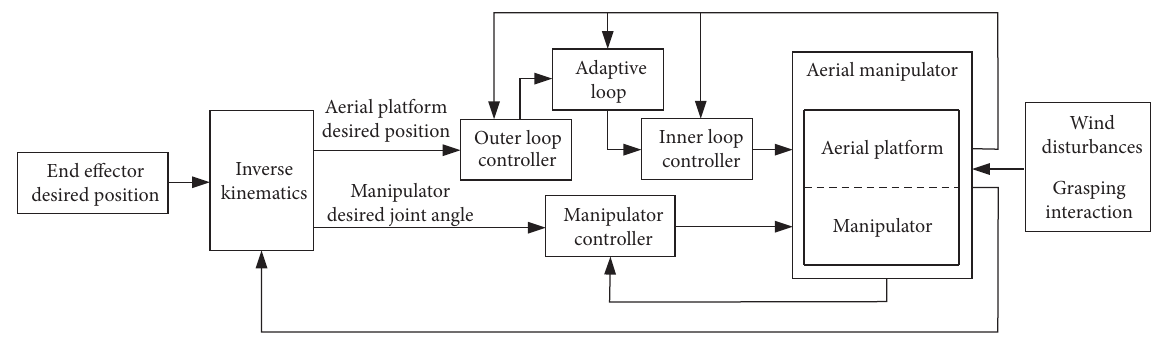
Figure 11: The architecture of the control